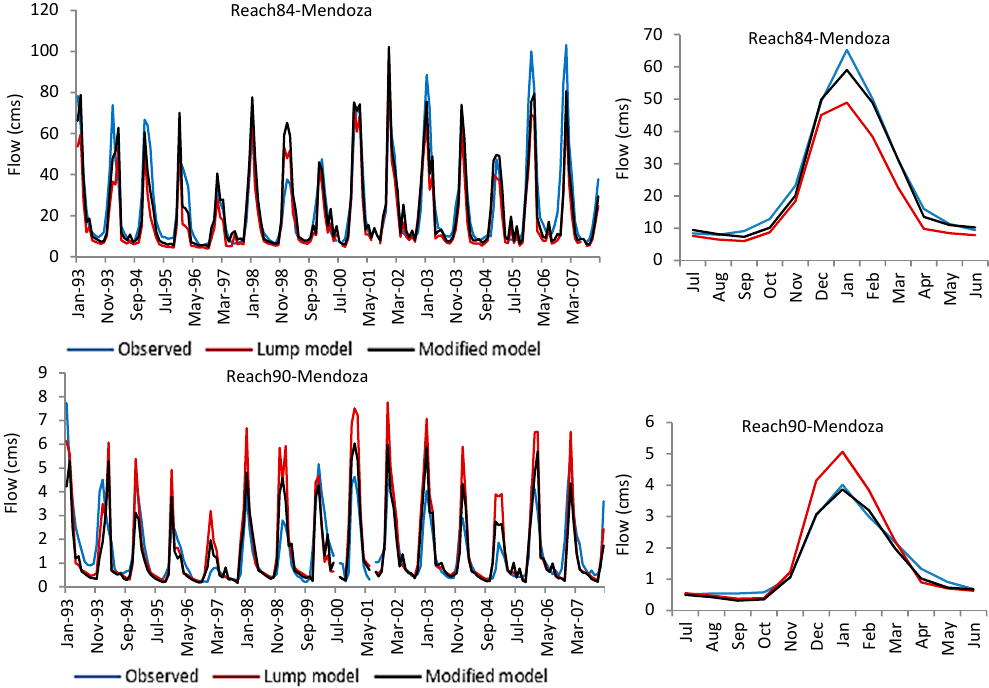
Figure 4. Observed and simulated monthly runoff and mean monthly runoff using SWAT with different melt algorithms for the calibration period at selected reached. Glacier free bands Below 2900 m.s.l.